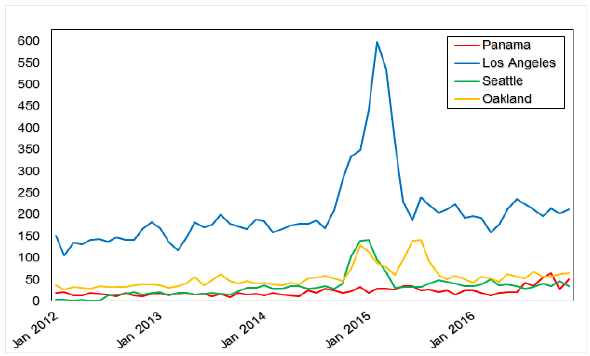
Figure 11 Variation of counted AIS’ positions per bin in Los Angeles, Seattle, Oakland and Panama port locations (2012-